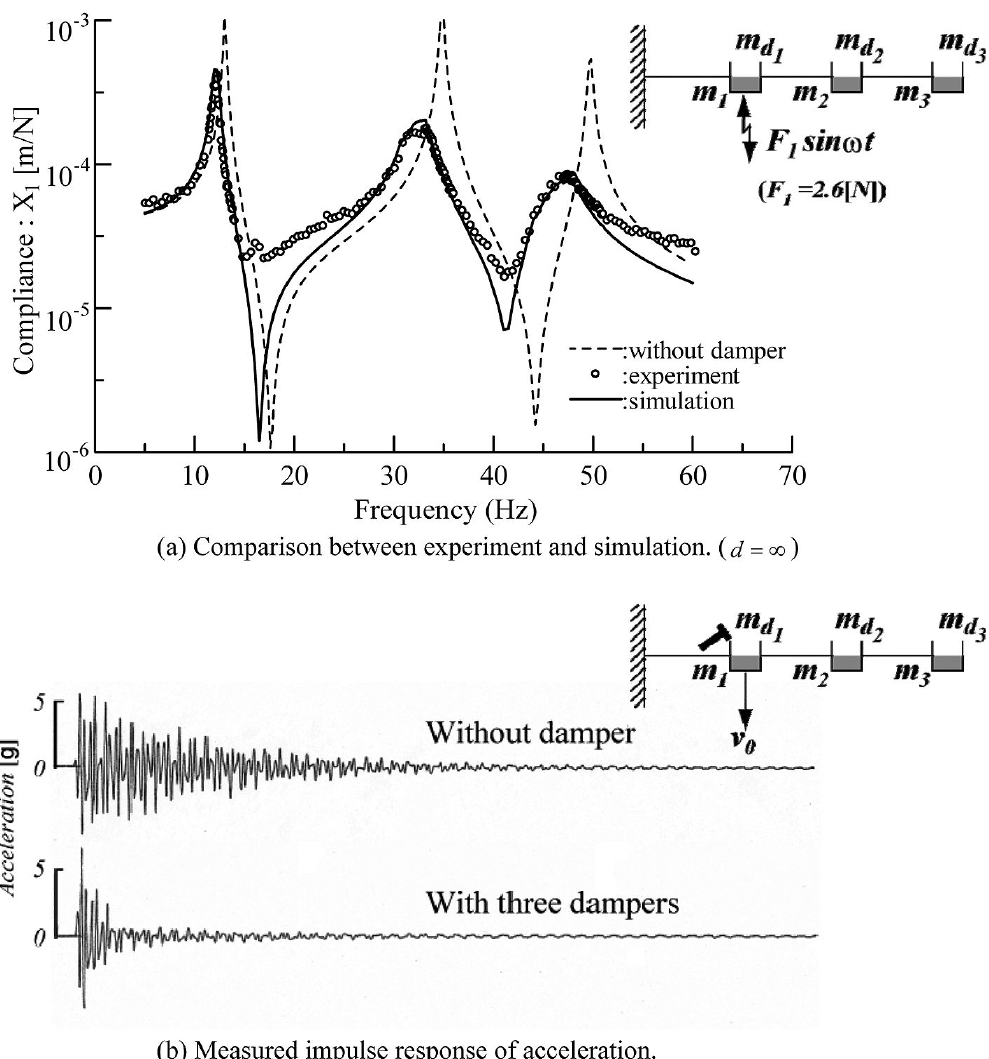
Fig. 10. Effectiveness of plural dampers ( N d =3 ). ( µ dj = 10% , d j = ∞ , j = 1 , 2 , 3 , F 1 = 2 . 6[ N ])